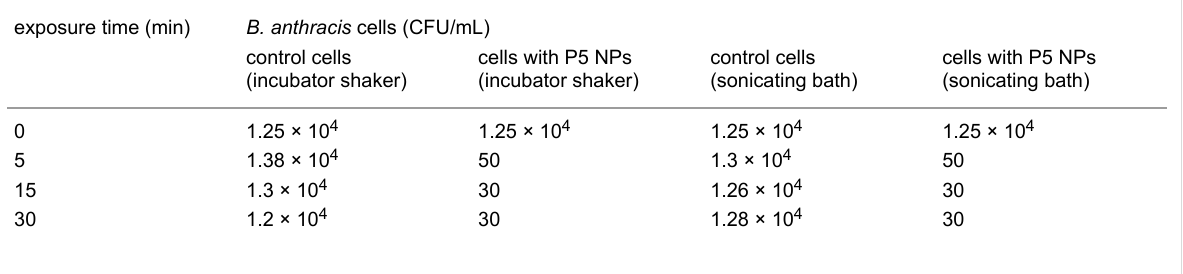
Table 1: Antibacterial activity of multi-armed CuO NPs (P5) against B. anthracis vegetative cells at 2mg/mL of P5 in saline – under sonication in ultra- sonic bath or shaking at 150 rpm in an incubator shaker (at 35 °C). exposure time